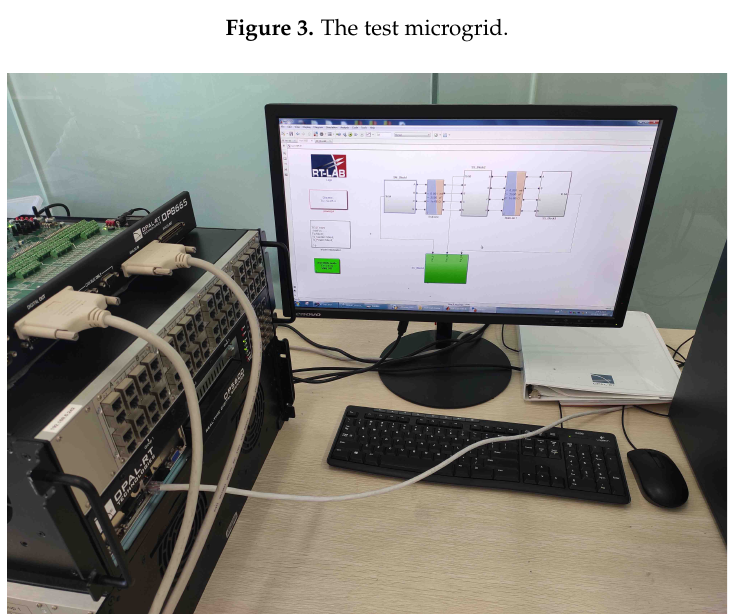
Figure 4. Photograph of the experimental